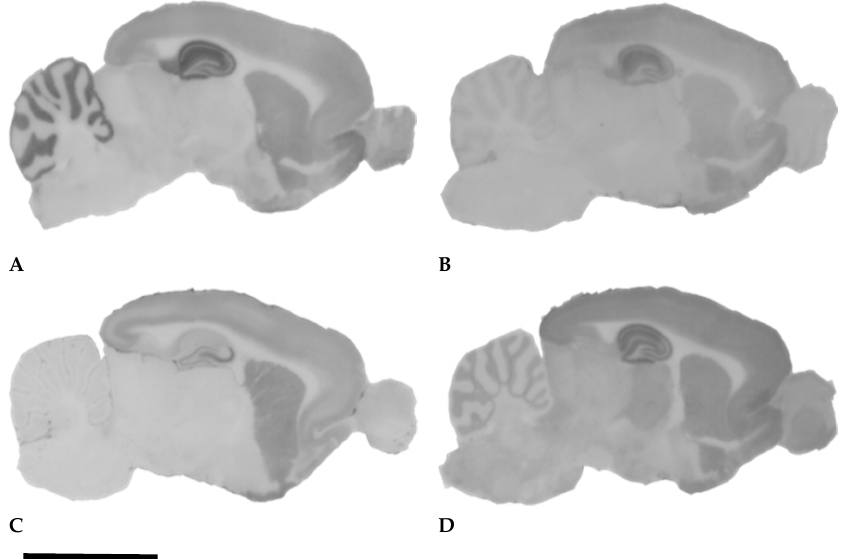
Figure 1. Histoblot images displaying the localization of the α -amino-3-hydroxy-5-methyl-4-isoxazole propionic acid (AMPA) receptor subunits GluA1-4 and GluA2 in the rat brain: GluA1-4 ( A ), GluA2 ( B ); the kainate receptor subunit GluK5 ( C ), and the N -methyl-D-aspartate (NMDA) receptor subunit GluN1 ( D ). Note the strong anti-GluA1-4 and anti-GluN1 staining of the dentate molecular layer; the stratum oriens (SO), stratum radiatum (SR), stratum lacunosum (SL), and stratum moleculare (SM) of the Ammon’s horn. The anti-GluK5 serum stains the stratum lucidum (SLUC) of CA3 strongly ( C ). The staining density of the dentate fascia and the SO in CA1 is medium ( C ). The granular and pyramidal layers display weak GluN1 immunoreactivity ( D ). The histoblot signal of the GluA2 subunit ( B ) is similar to that of the GluA1-4, although weaker. We noticed that the CA1 region with anti-GluA2 was labeled stronger than the rest of the Ammon’s horn ( B ) [16]. See Appendix A for methods. Bar: 1